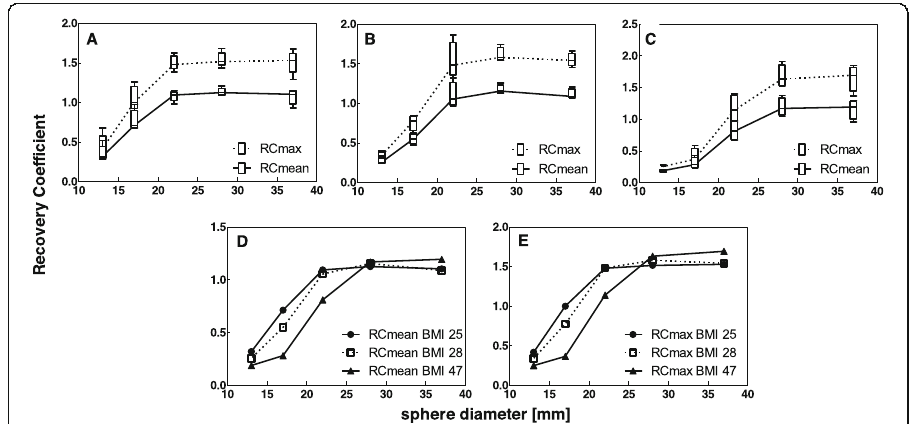
Fig. 6 RC per sphere diameter for ( a ) small phantom (BMI, 25 kg/m 2 ), ( b ) medium phantom (BMI, 28 kg/m 2